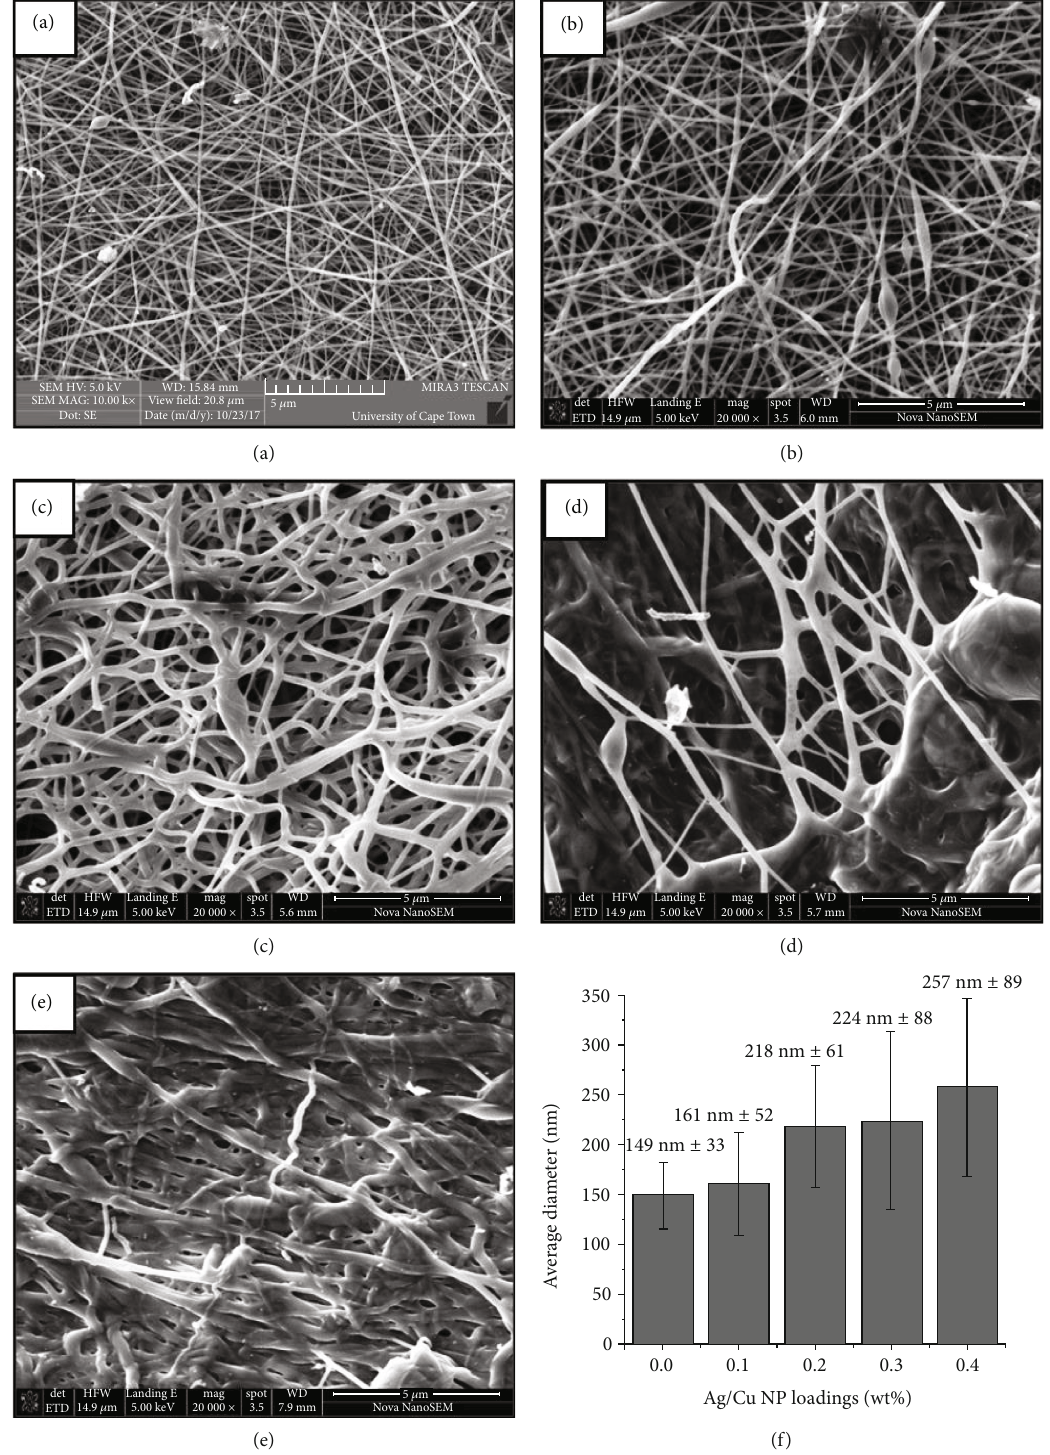
Figure 7: SEM images and fi ber distribution of the 30/70 CS/PVA blend with di ff erent Ag/Cu nanoparticle loadings of (a) 0wt%, (b) 0.1wt%, (c) 0.2wt%, (d) 0.3 wt%, and (e) 0.4wt%. Voltage: 20 kV; distance: 15